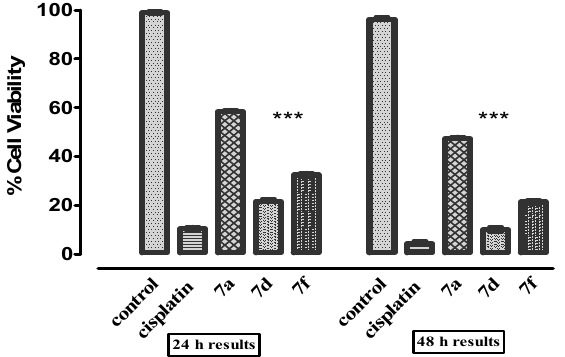
Figure 10. Depiction of % cell viability results of cervical cancer cells (HeLa cells) after treatment with potent derivatives ( 7d and 7f ) and cisplatin. Data were investigated as mean of three experiments ± S.D. ( n = 3), using PRISM 5 (GraphPad, San Diego, CA, USA). (*** p < 0.005, significant result.)